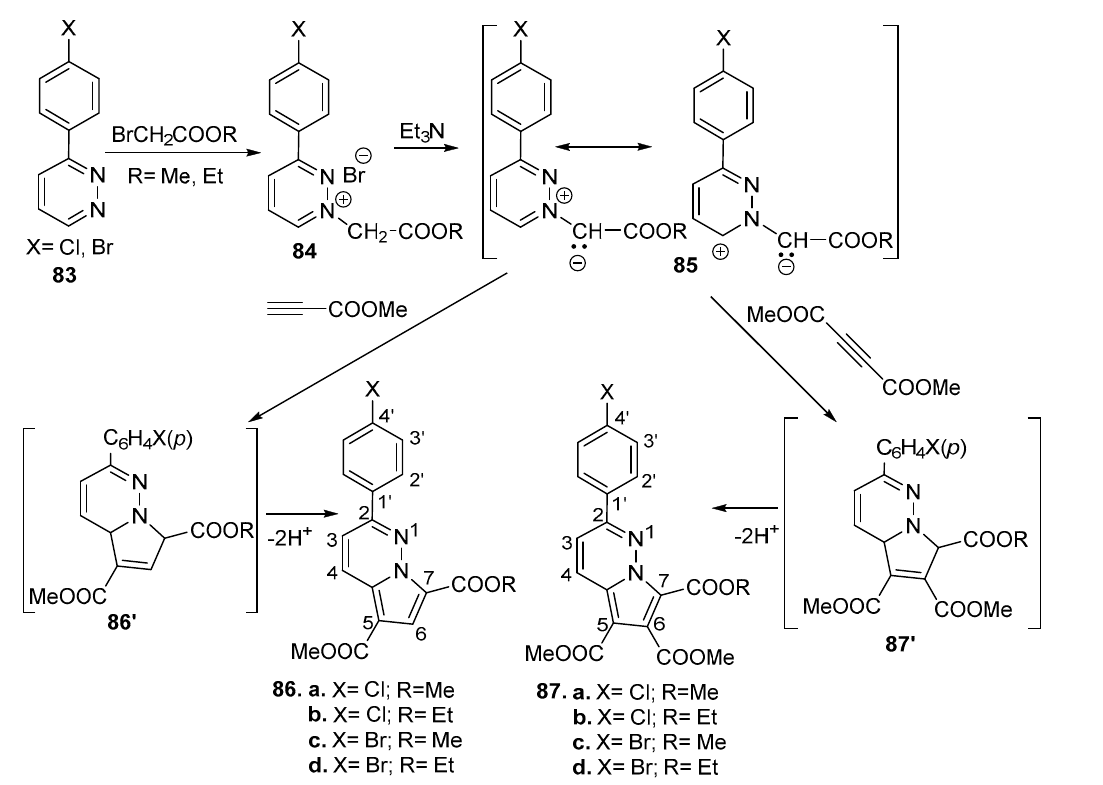
Molecules 2022 , 27 , x